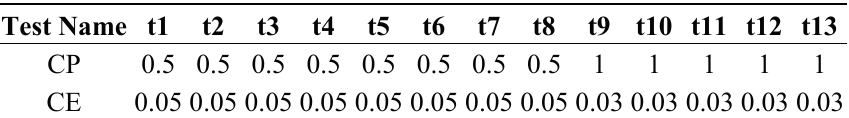
Table 8. Test cost of the case.